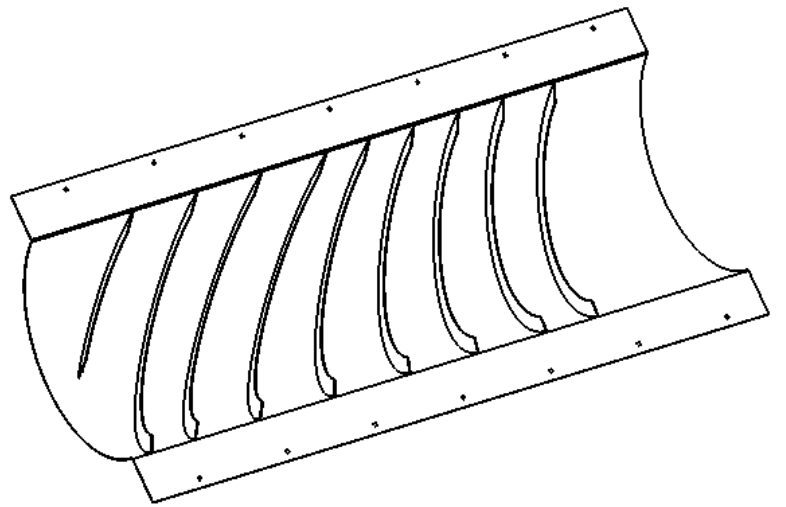
Figure 6. Threshing room upper cover